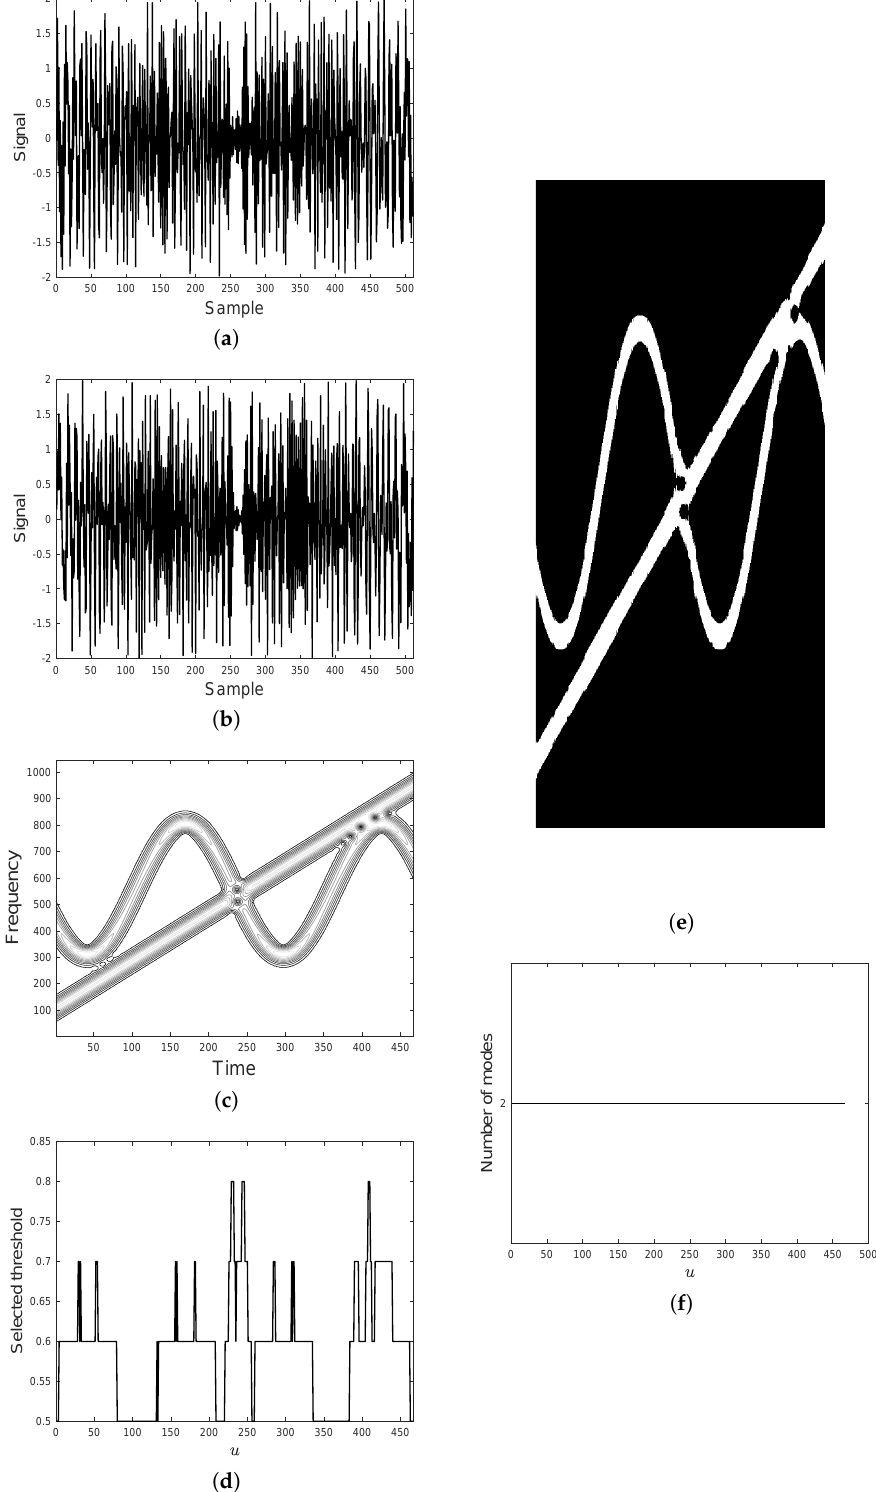
Figure 22. ( a ) Real part of a two-component complex signal, whose modes respectively have sinusoidal and linear frequency modulation ( b ) Imaginary part of the same signal. ( c ) Spectrogram, s = 46. ( d ) Optimal threshold provided by MDL functional minimization, according to Equation (18). ( e ) Binary map derived from ( c ). ( f ) Estimated number of